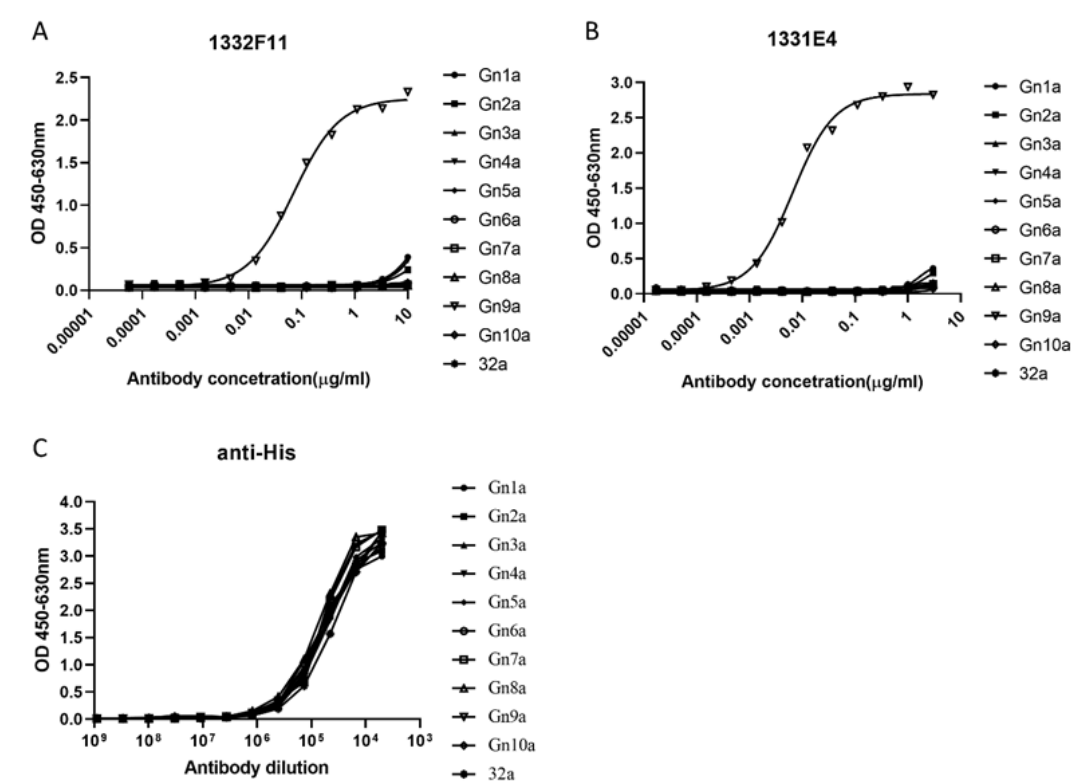
Figure 4. ELISA analysis of NAbs to Gn truncated segments. ( A , B ) The truncated segments, coated at 0.2 µ g / well in a 96-well plate, were incubated with threefold serial dilutions of the indicated NAbs. 1332F11 and 1331E4 were diluted at 10 µ g / mL and 3 µ g / mL in an initial well, respectively. 32a represents pET-32a empty vector. ( C ) The anti-His antibody (1:5000 initial dilution) was used as positive control. The optical density (OD) was measured at OD 450 –OD 630 . Sigmoid curves were generated through GraphPad Prism 8. Sigmoid neutralizing curves were generated through GraphPad Prism 8.